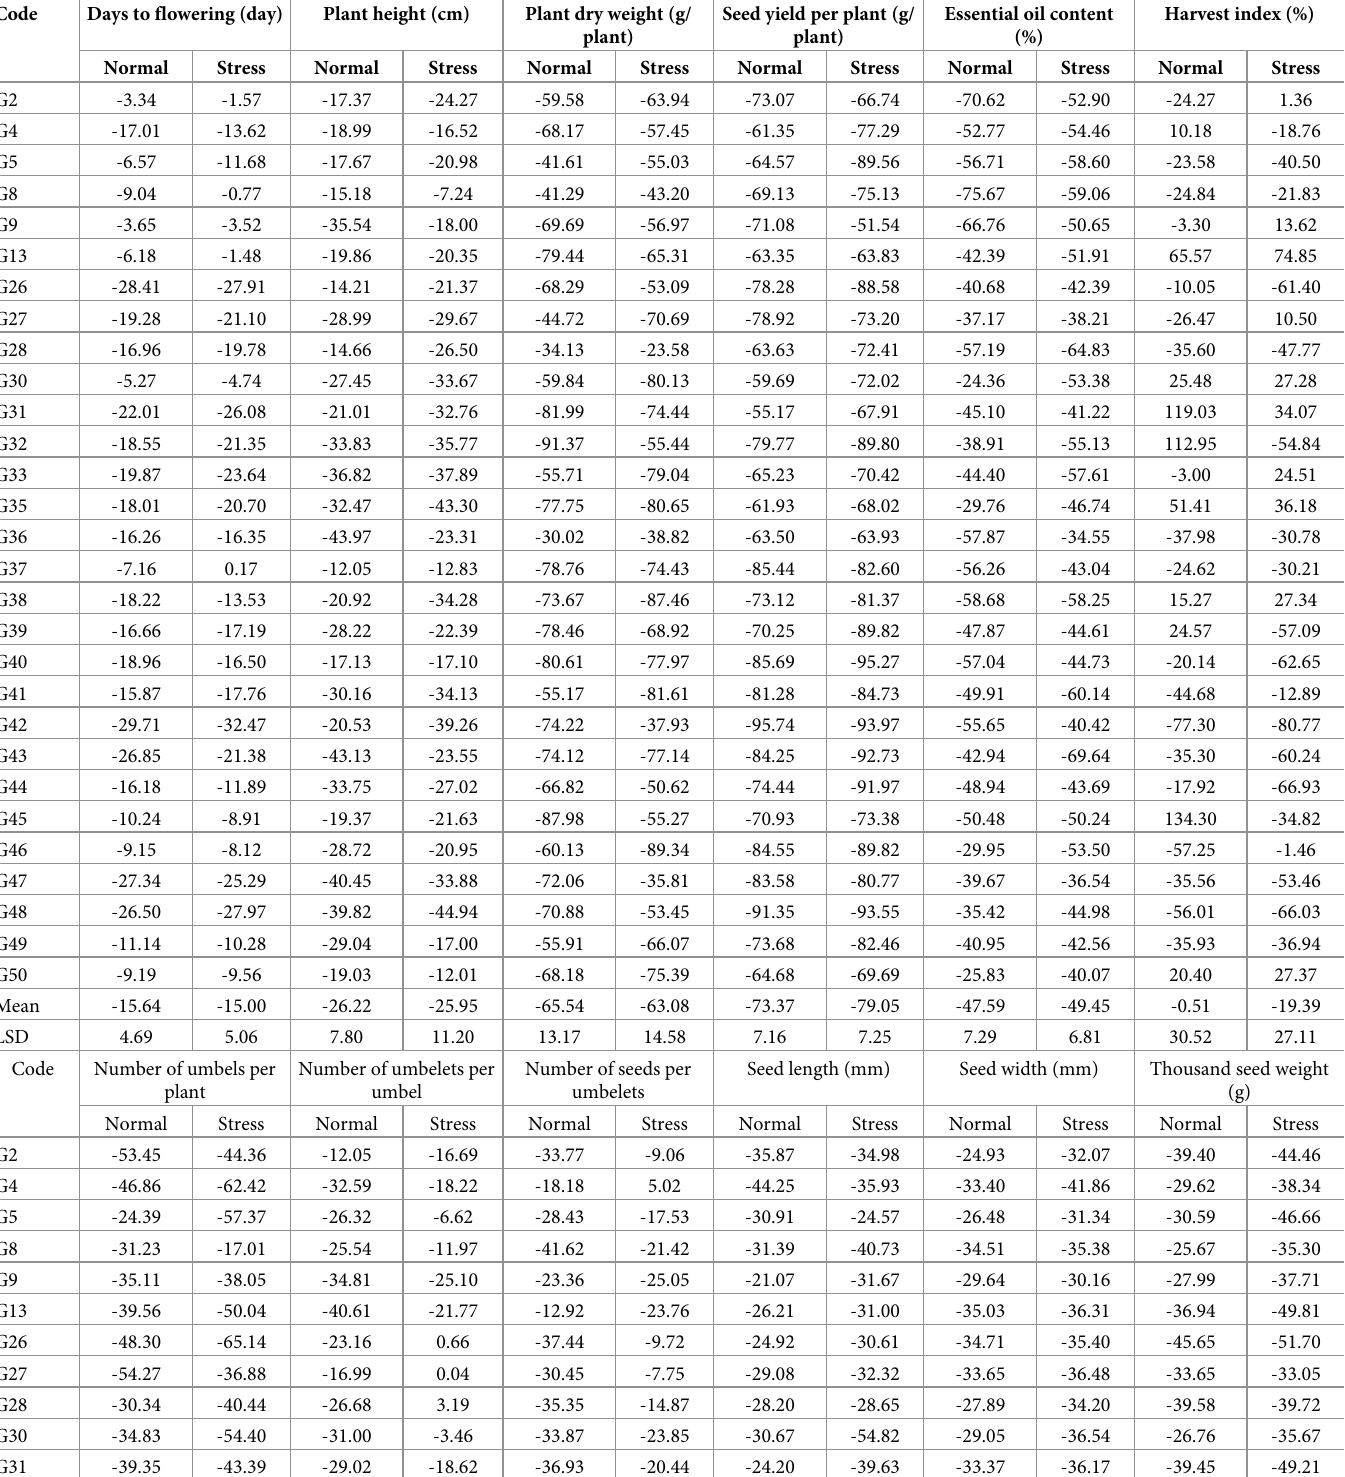
Table 4. The percentage of inbreeding depression in some important traits of selfed fennel genotypes (S1) under normal and water deficit conditions during two years (2019–2020).